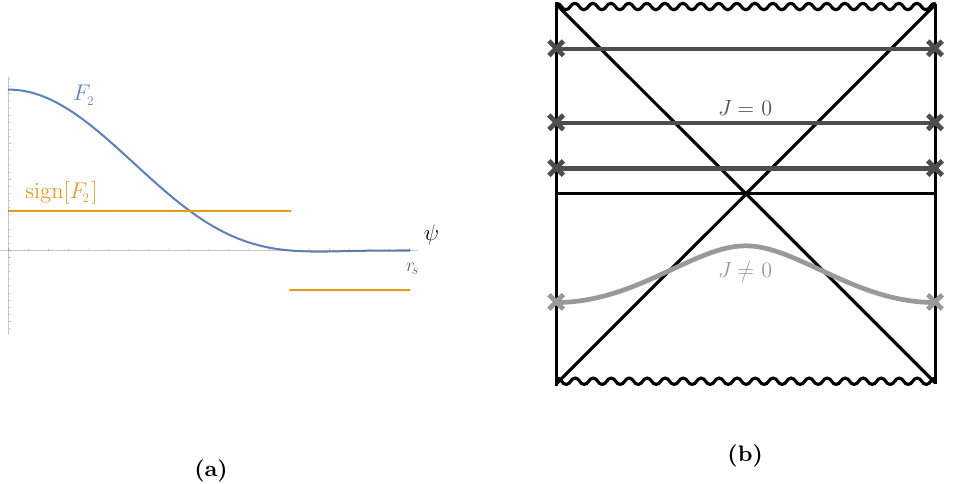
Figure 10. (a) A plot of a generic result for F 2 in BTZ is presented. Notice that the fact that the first QN mode is pure imaginary results in the system only admitting a single absorption and re-emission process throughout the BHs history. Notice that since the horizontal axis is ψ ∈ [0 , r and describes the complete BH history. (b) We plot some geodesics in the BTZ BH in dark grey to show that the ˙ t = 0 are also ˙ T = 0 curves at J = 0 . Of course, for J 6 = 0 the geodesics bend, as we show in a lighter tone of grey